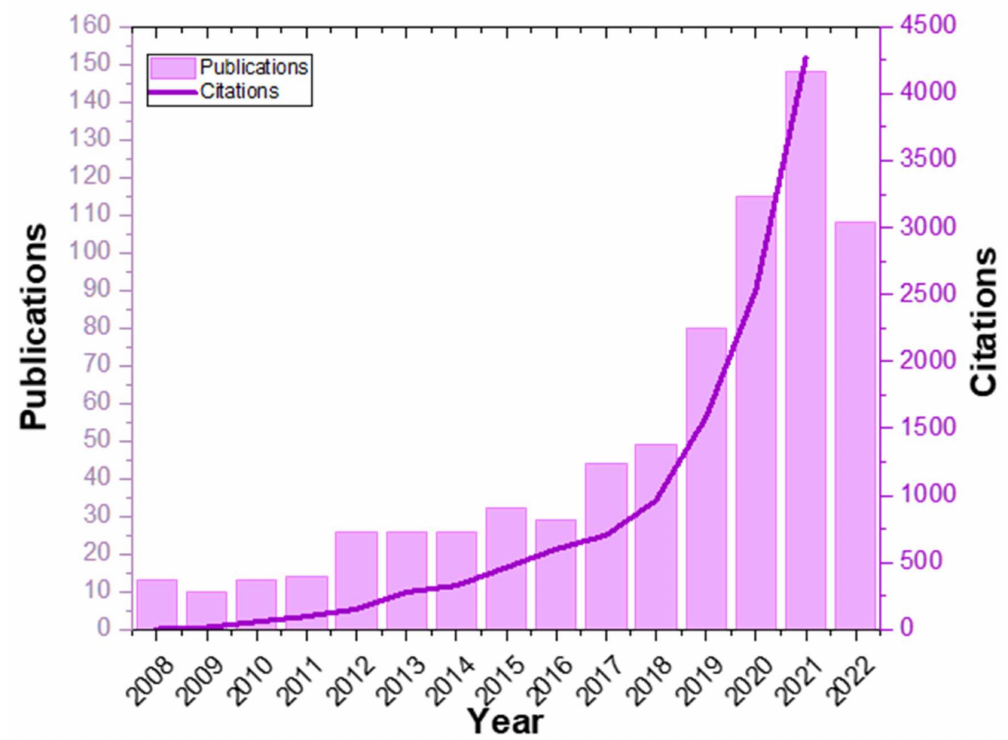
Figure 2. The number of publications and citations for indicators with anthocyanins, as it has evolved during the last years (2008–2022). (Search query in Web of Science: (ALL = (anthocyanins)) AND ALL = (indicators), retrieved 1 September